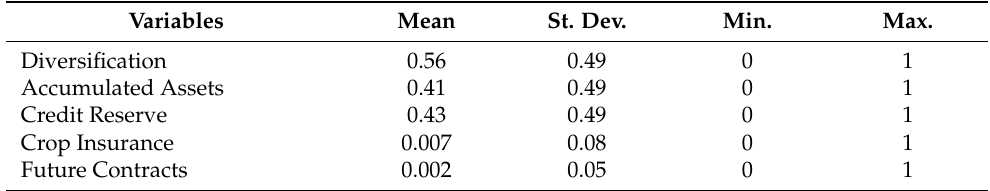
Table 7. Distribution of Risk Management Strategies Adopted by Sampled